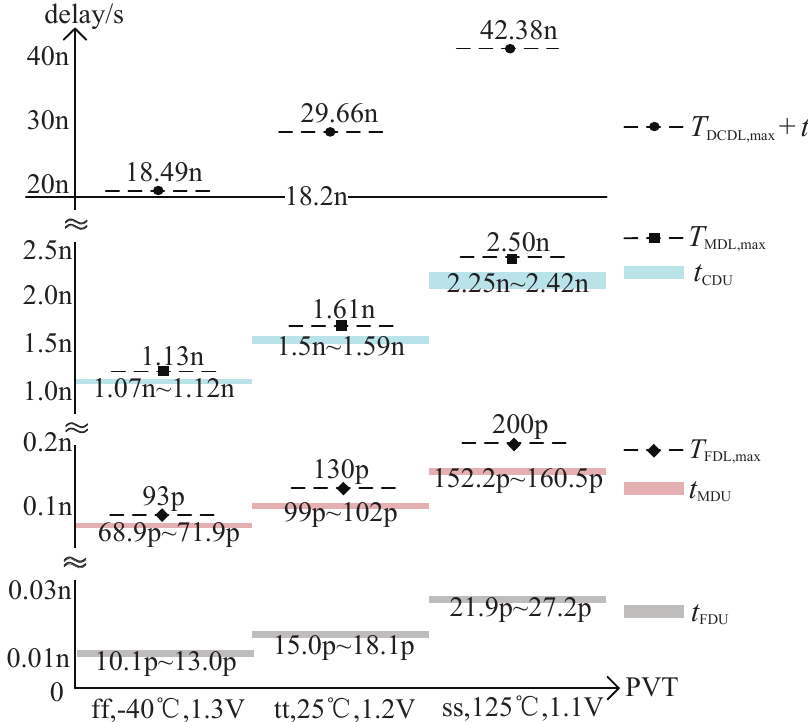
Figure 14. The delay range and unit delay of sub-lines under different PVT